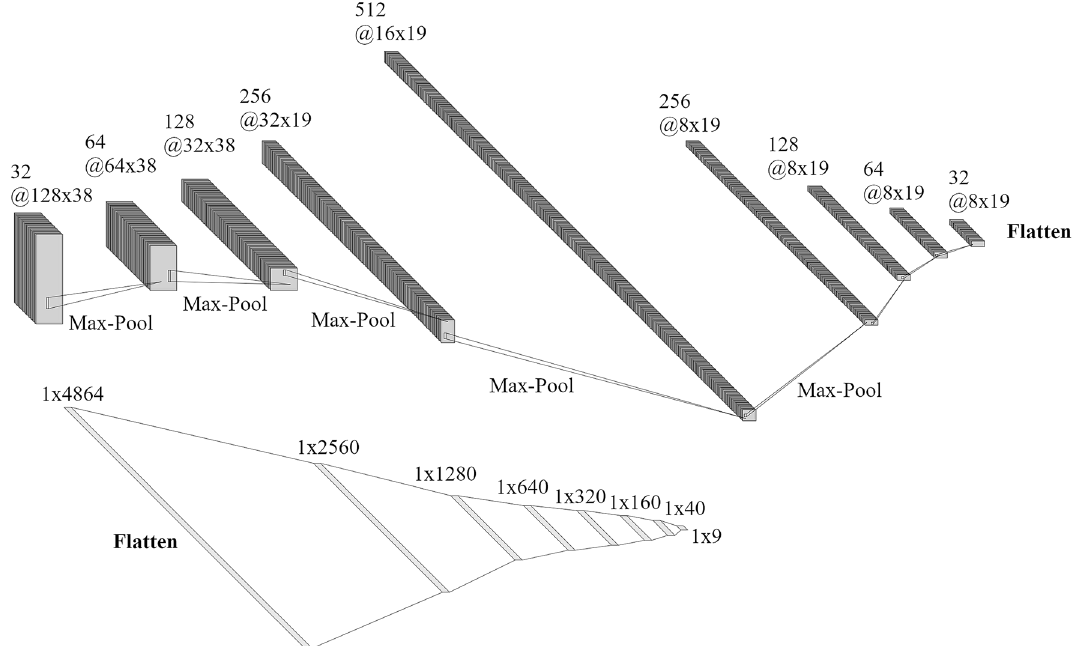
Figure 8. DCNN architecture used in this work. Top: first part of the network with convolutional and pooling layers. After the last convolutional layer the output is flattened and input into a fully connected network (bottom). All layer outputs, except for the output layer, are batch-normalized and activated with a swish function. This figure was prepared using schematics drawed with NN-SVG 106